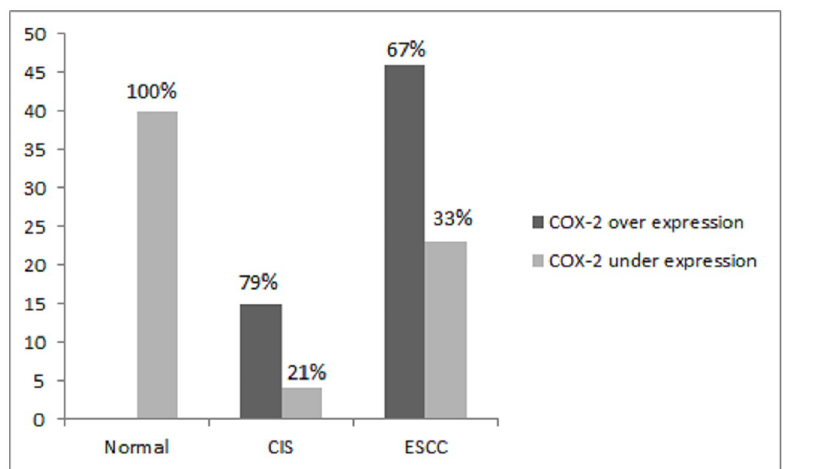
Fig 2. Expression of COX -2 in normal healthy mucosa, CIS and ESCC.